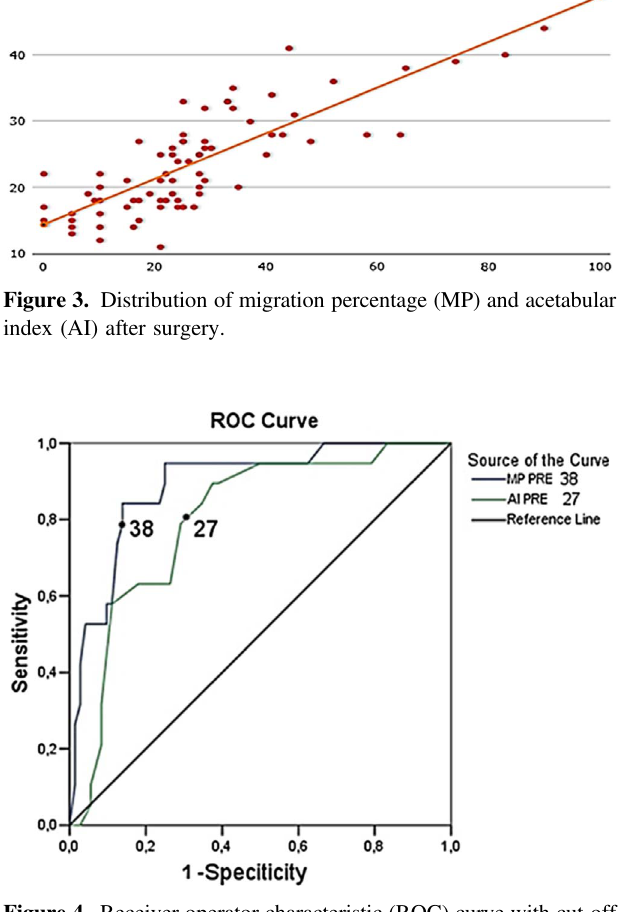
Figure 4. Receiver operator characteristic (ROC) curve with cut-off values of 38% (AUC 0.897) for migration percentage (MP), and 27 (cid:1) (AUC 0.769) for acetabular index (AI), before (PRE) surgery.